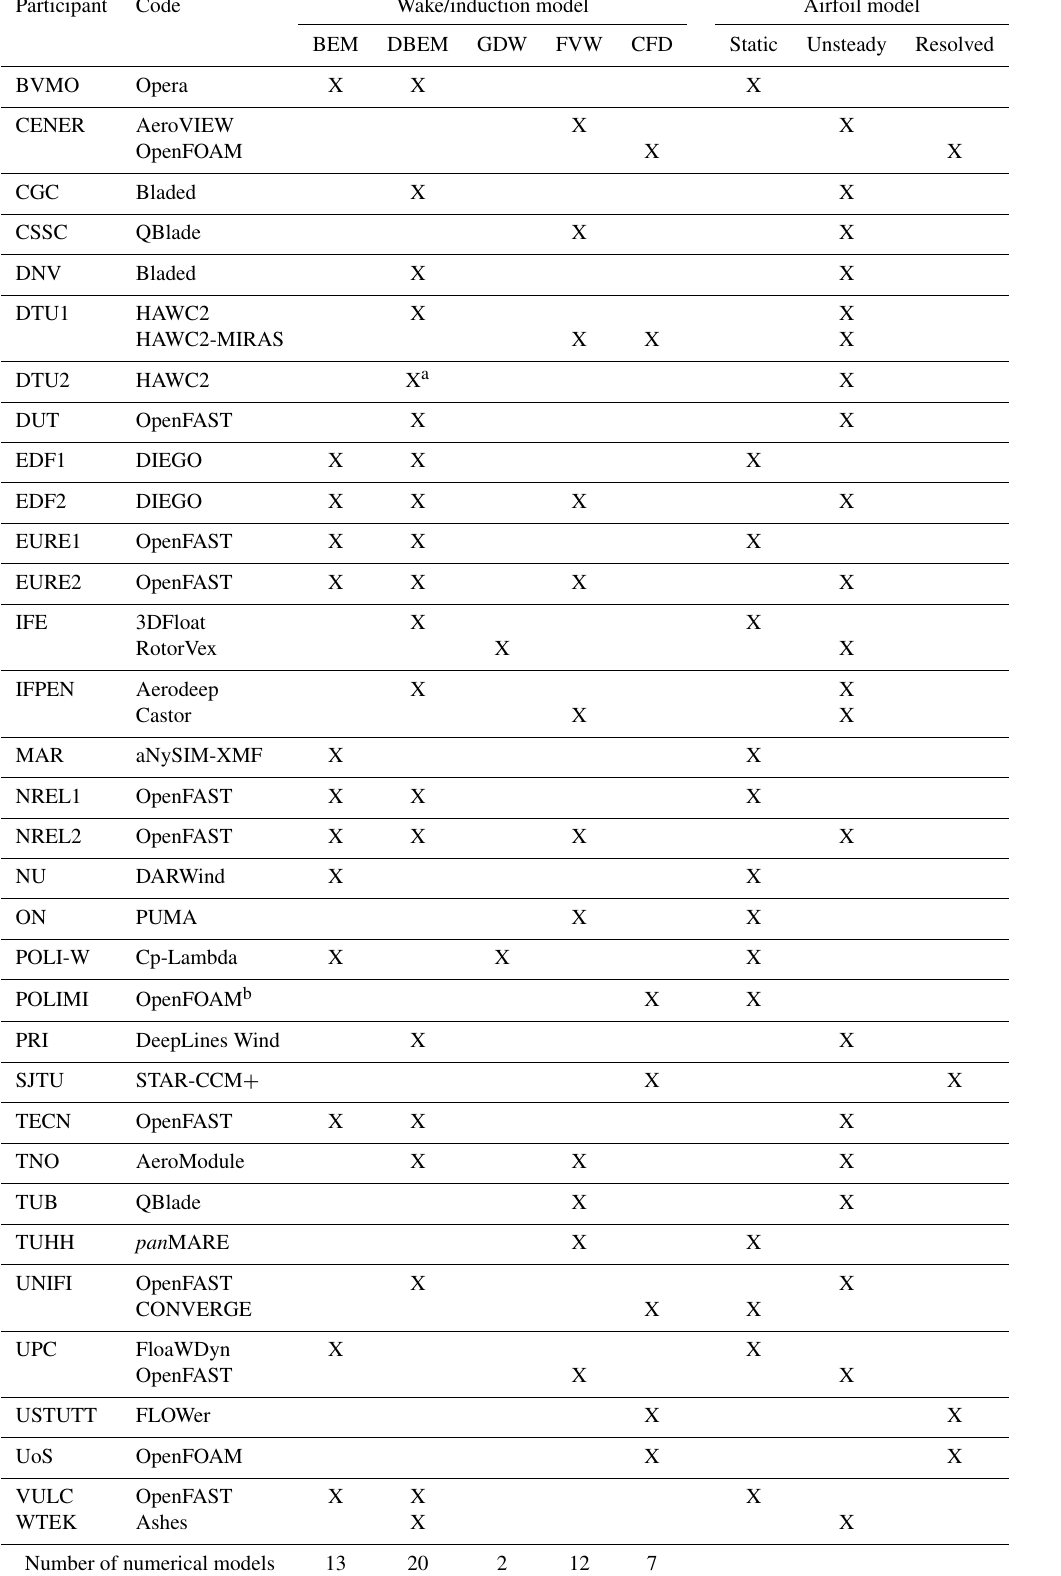
Table 3. Summary of participants, codes, and modeling approach used.